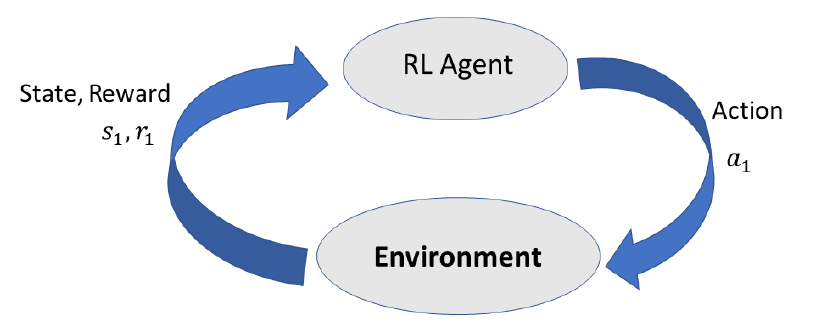
Figure 2. Reinforcement learning